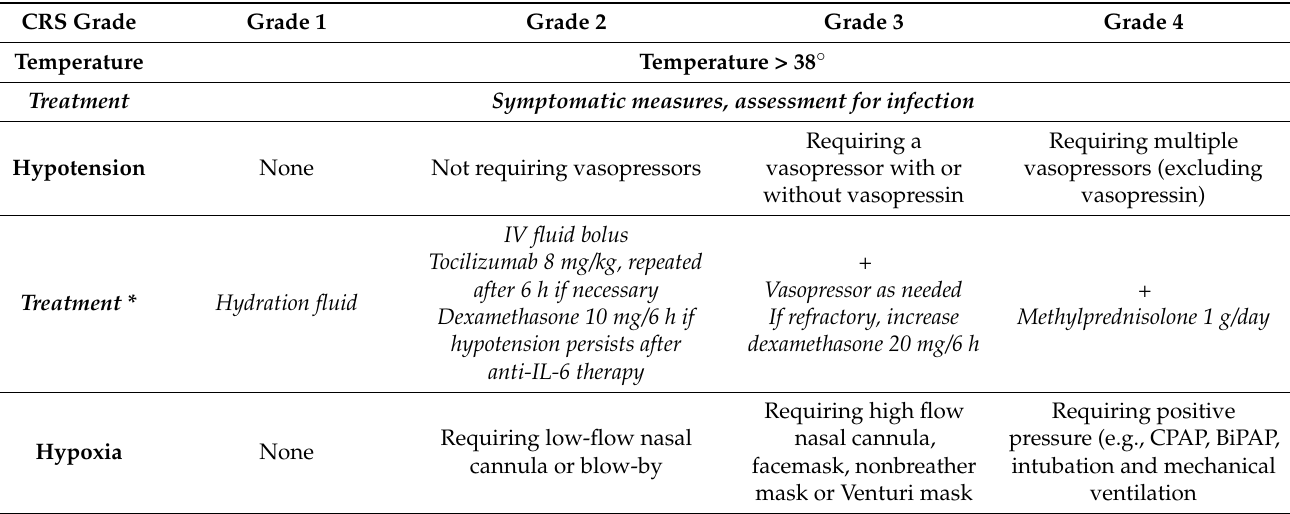
Table 3. American Society for Transplantation and Cellular Therapy consensus grading for cytokine release syndrome and treatment (adapted from